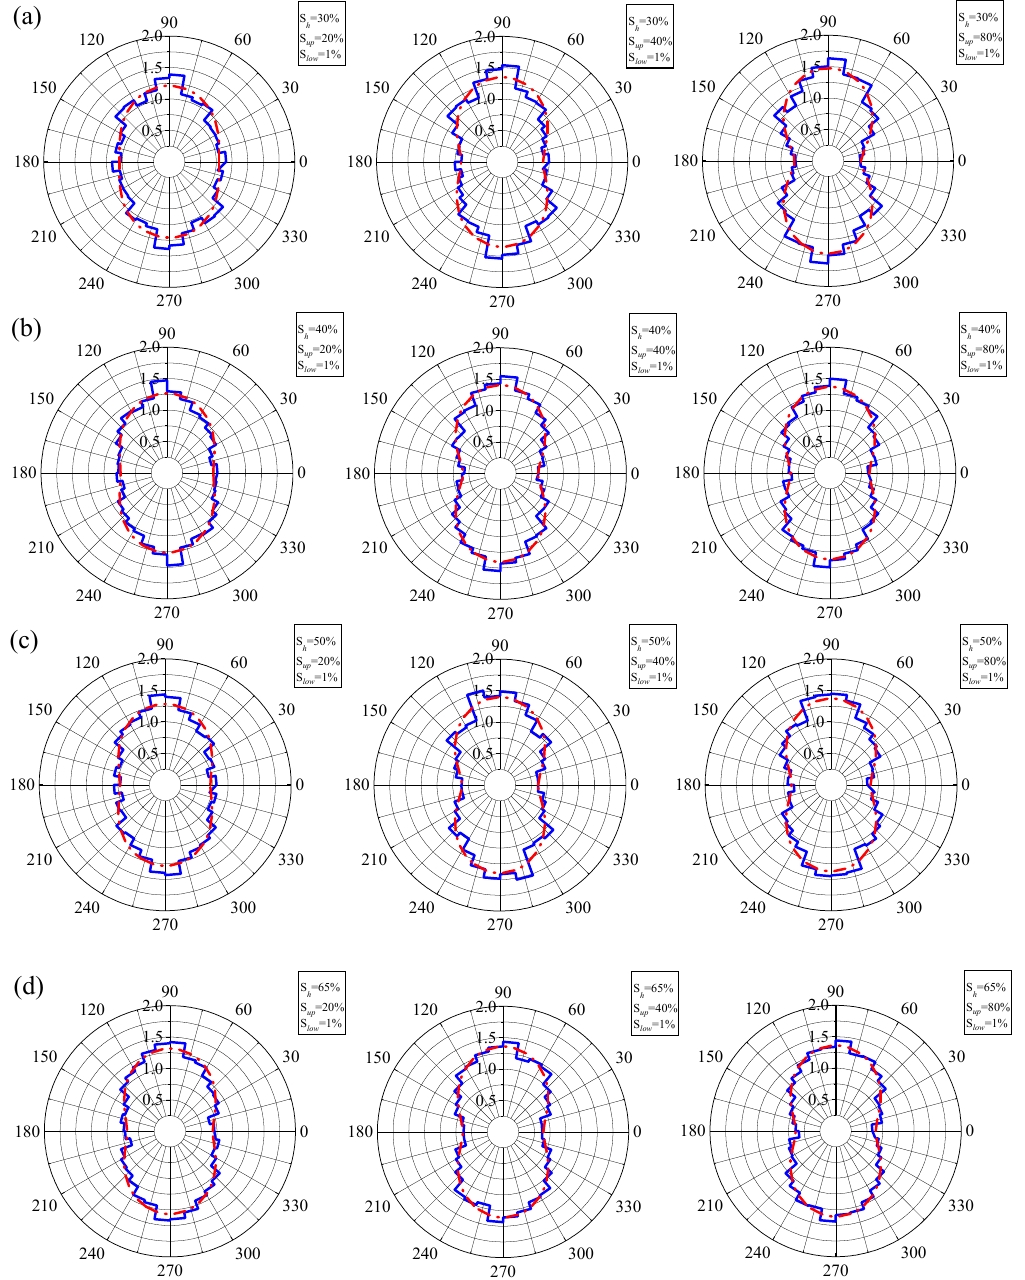
Figure 14. The evolution of the normal contact force between the particles under different dynamic amplitude conditions for MHS with different S h values. (a) S h = 30%; (b) S h = 40%; (c) S h = 50%; (d) S h = 65%.